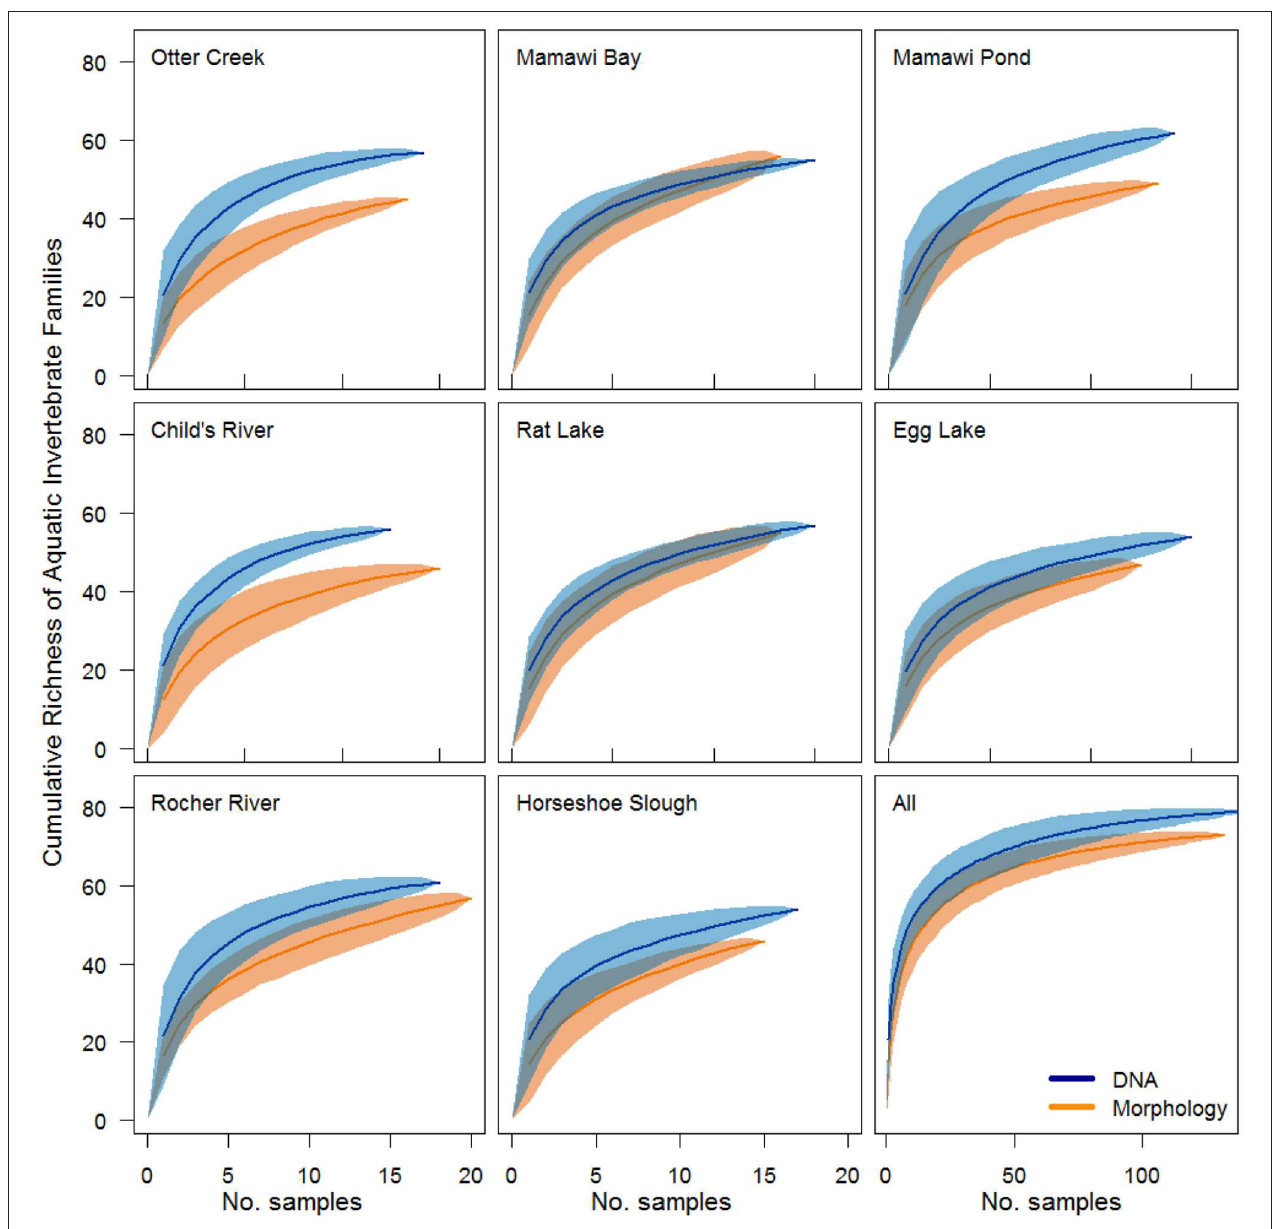
FIGURE 2 | Accumulated richness (mean ± 95% confidence interval) of aquatic invertebrate families from 8 wetland sites in the Peace-Athabasca Delta, and for all samples combined (note different scale) using DNA metabarcoding and morphological identification. Metabarcoded sequences were aggregated and restricted to the same taxa as observed in the morphological dataset for the entire